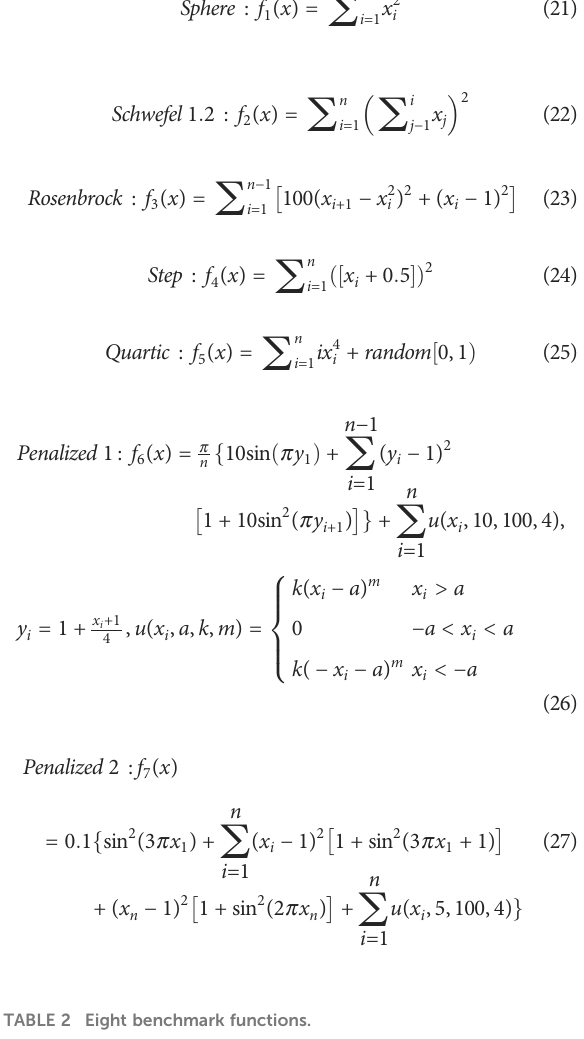
algorithm solution. In order to eliminate the randomness of the algorithm, 30 independent experiments are carried out on 6 WOAs. The experimental results are shown in Table 4.